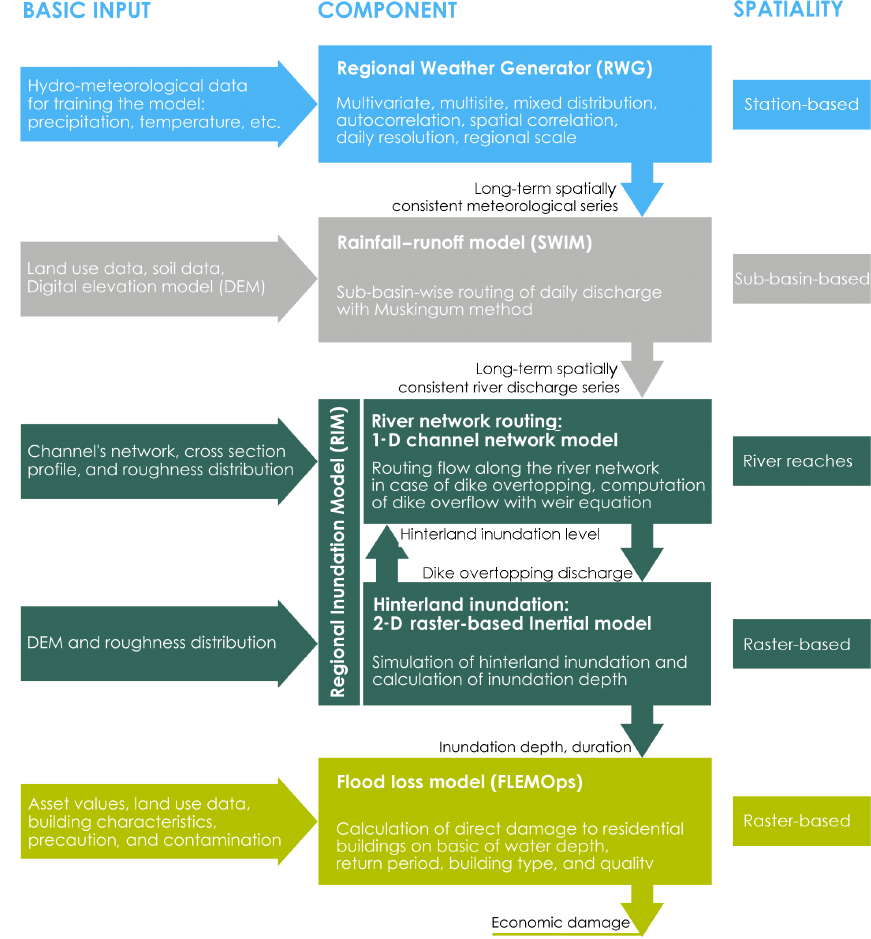
Figure 2. Flood risk model chain: regional flood model